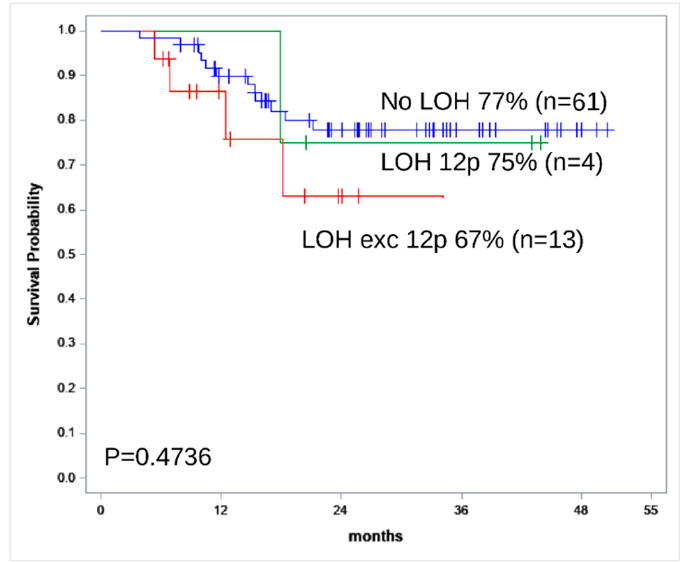
Figure 2. Kaplan–Meier survival curve for OS estimates according to the LOH status in tumor STR profile (LOH (except LOH 12p), red line; LOH 12p, green line; no LOH, blue line). Four patients with LOH 12p and additional LOH in several loci and five patients with unidentified LOH status were excluded from analysis. Table 2. The main characteristics of B-ALL patients according to the LOH status. p -value from χ 2 was used to estimate significance for the tables of 2 ×